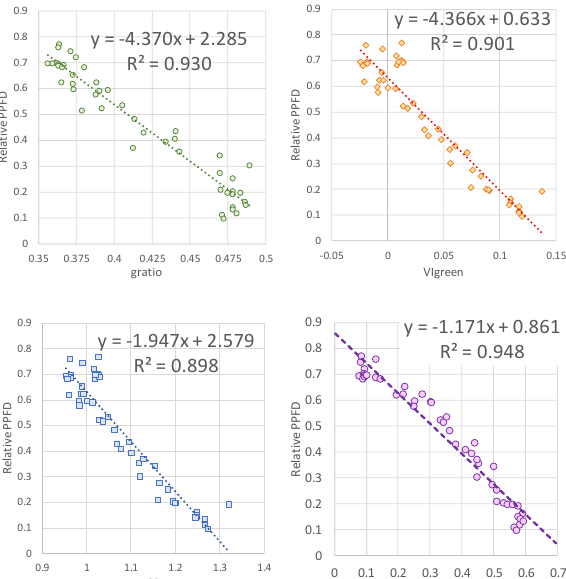
Figure 7. Relations of relative PPFD with gratio , VIgreen , GR and VC